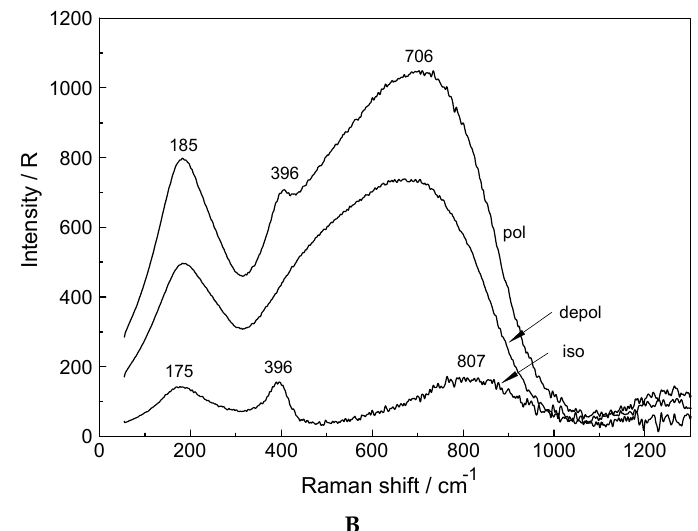
Figure 4. ( A ). Raman scattering profiles in R-format (from top to bottom: polarized, depolarized and isotropic scattering) of a 3.199 mol·L − 1 LuCl 3 solution. Note, the downshift of the Lu-O mode to 390 cm − 1 compared to the one in Lu(ClO 4 ) 3 (aq) (compare Figure 2) is due to the substitution of Cl − for a water molecule in the first hydration sphere, forming [Lu(OH 2 ) 7 Cl n ] 2+ . The extremely broad mode at 672 cm − 1 is due to the librational water band influenced by the solute. The mode at 192 cm − 1 is due to the restricted O-H···O band of H 2 O and the broad feature at ~251 cm − 1 is assigned to [Lu(OH 2 ) 7 Cl] 2+ . ( B ). Raman scattering profiles in R-format (from top to bottom: Polarized, depolarized and isotropic scattering) of a 0.478 mol·L − 1 LuCl 3 solution. Note, the ν 1 Lu-O mode at 396 cm − 1 for [Lu(OH 2 ) 8 ] 3+ . The extremely broad mode at 807 cm − 1 in R iso (R pol : 706 cm − 1 ) is due to the librational water band influenced by the solute. The mode at 175 cm − 1 (R iso ) is due to the restricted translation O-H···O band of H 2 O. Molecules 2018 , 23 , x FOR PEER REVIEW